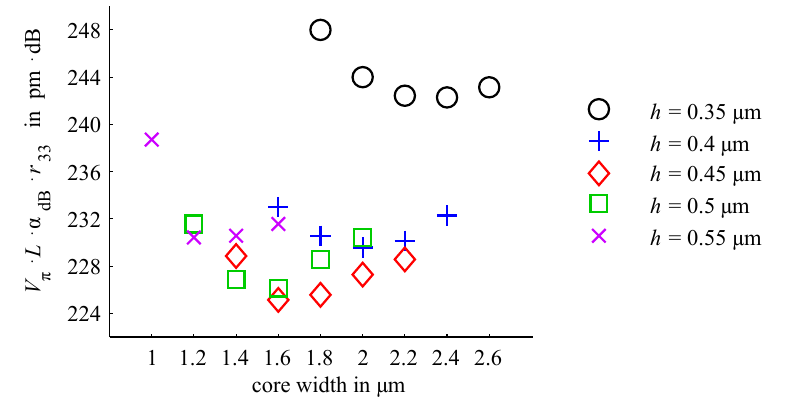
Figure 8. Results of the simulations to optimize the core dimensions at a core refractive index of 1.99 and an EO polymer refractive index of 1.7.